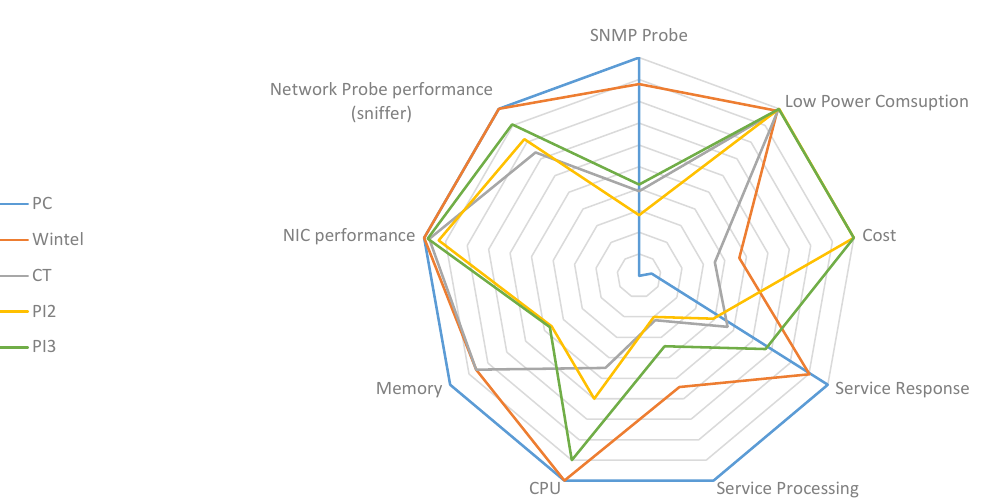
Figure 12. Comparative summary of the results obtained in the first scenario.